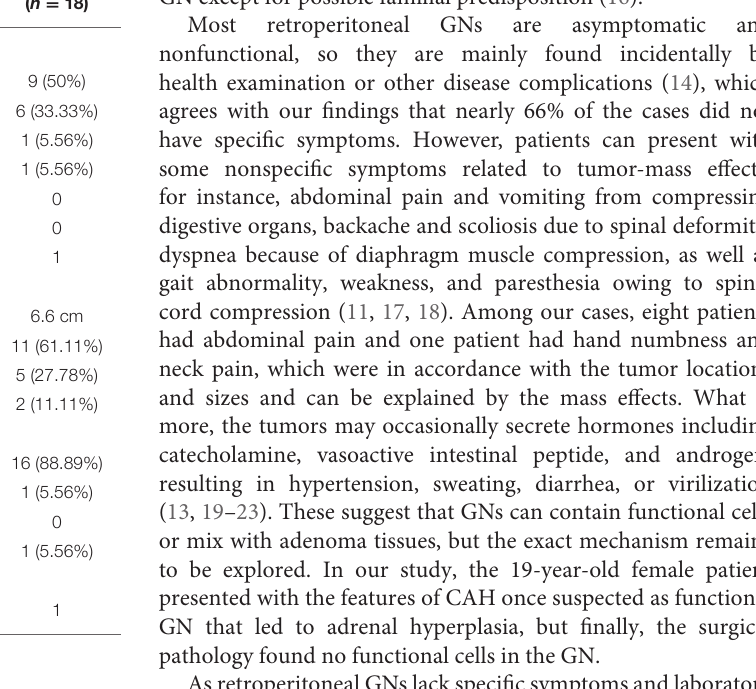
Laparotomy Laparoscopic ( n = 12)